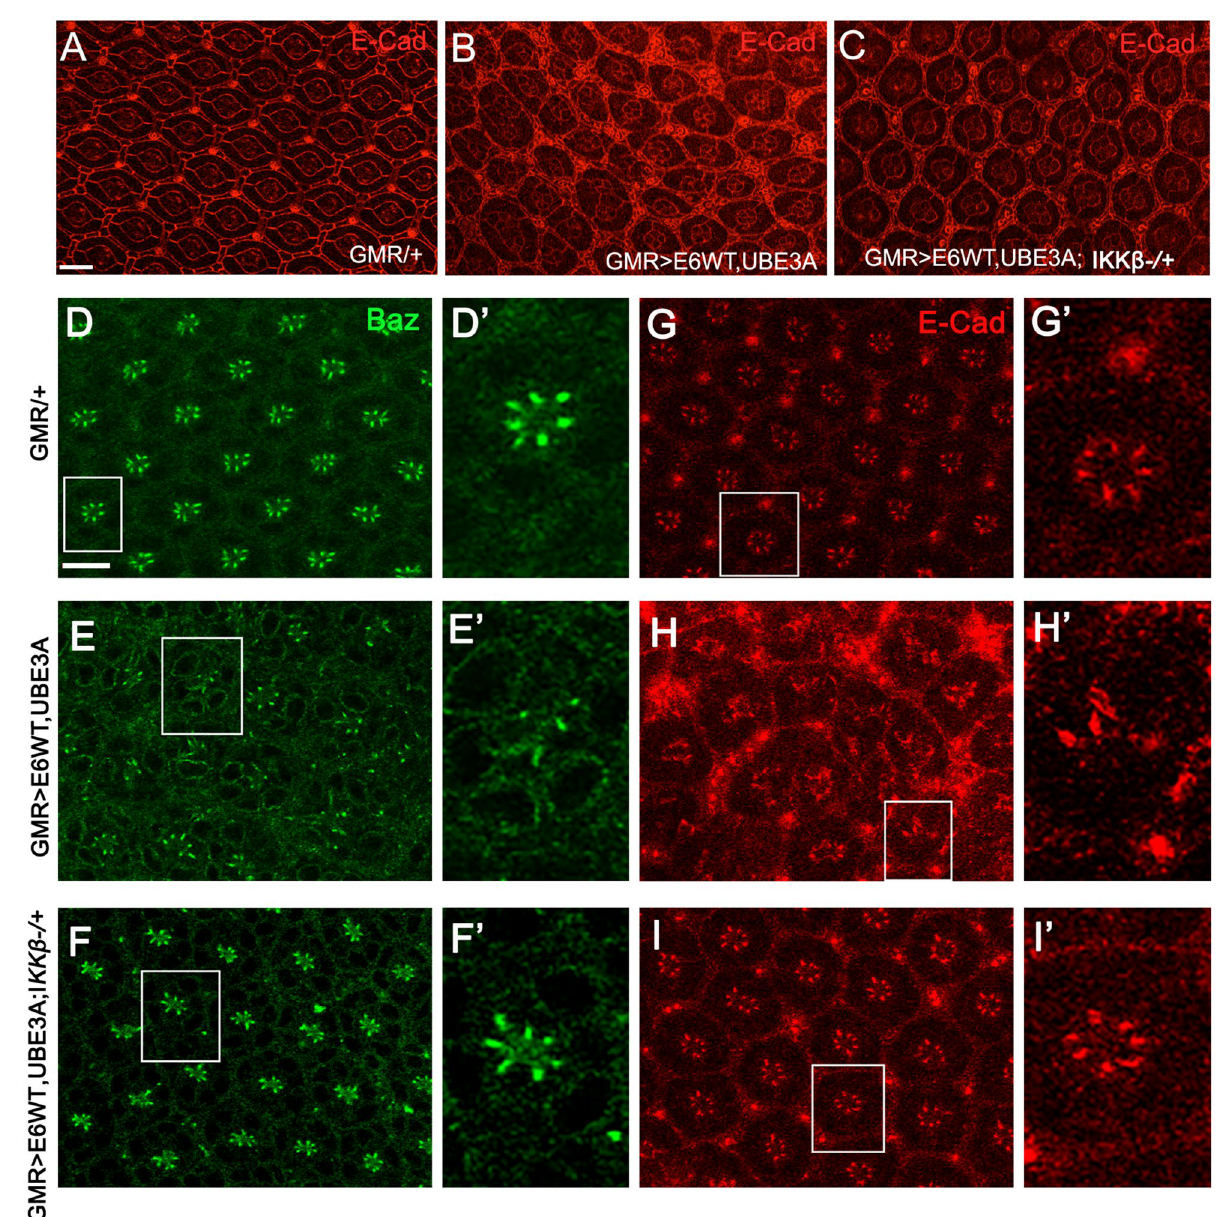
Figure 3. Reduction of IKKβ suppresses the cellular abnormalities and restores the cell polarity and junctional integrity disrupted by E6 + UBE3A co-expression. ( A–C ) Pupal eyes showing E-Cad immunolabeling. ( A ) Expression of GMR-Gal4, showing a normal stereotype pattern of ommatidia. ( B ) Co-expression of E6 and UBE3A causes severe abnormalities, including increase in number of pigment cells, bristle cells, and fusion of neighboring ommatidia. ( C ) A mutated copy of the IKKβ gene suppresses the E6 + UBE3A abnormalities. ( E–H ′ ) Co-expression of E6 and UBE3A causes disruption of cell polarity and junctional complex, as shown by loss of Bazooka (Baz) and E-Cad from photoreceptor cells. This is in comparison with ( D–G ′ ) where Baz and E-Cad are both localized correctly in each photoreceptor. ( F–I ′ ) A mutated copy of IKKβ gene in eyes expressing E6 and UBE3A restores the polarity and junctional integrity as is shown by the correct localization of Baz and E-Cad. Scale bars indicate 10 µm. Insets are digitally magnified 200%. Results shown are representative of those of 5 different